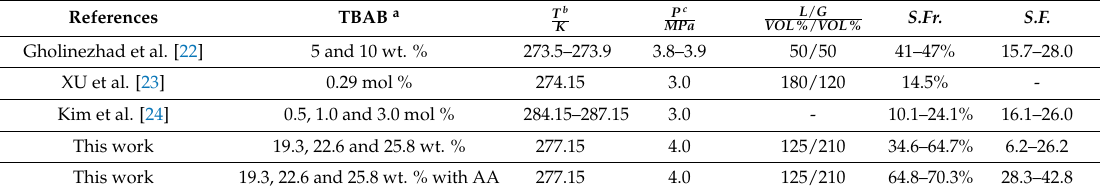
Table 4. Comparison of CO 2 separation results using TBAB as the